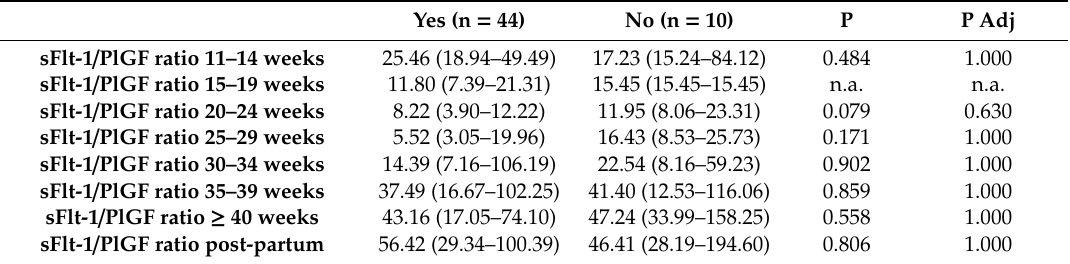
Table 4. E ff ect of low-dose aspirin (LDA) on sFlt-1 / PlGF ratio in women with adverse obstetric